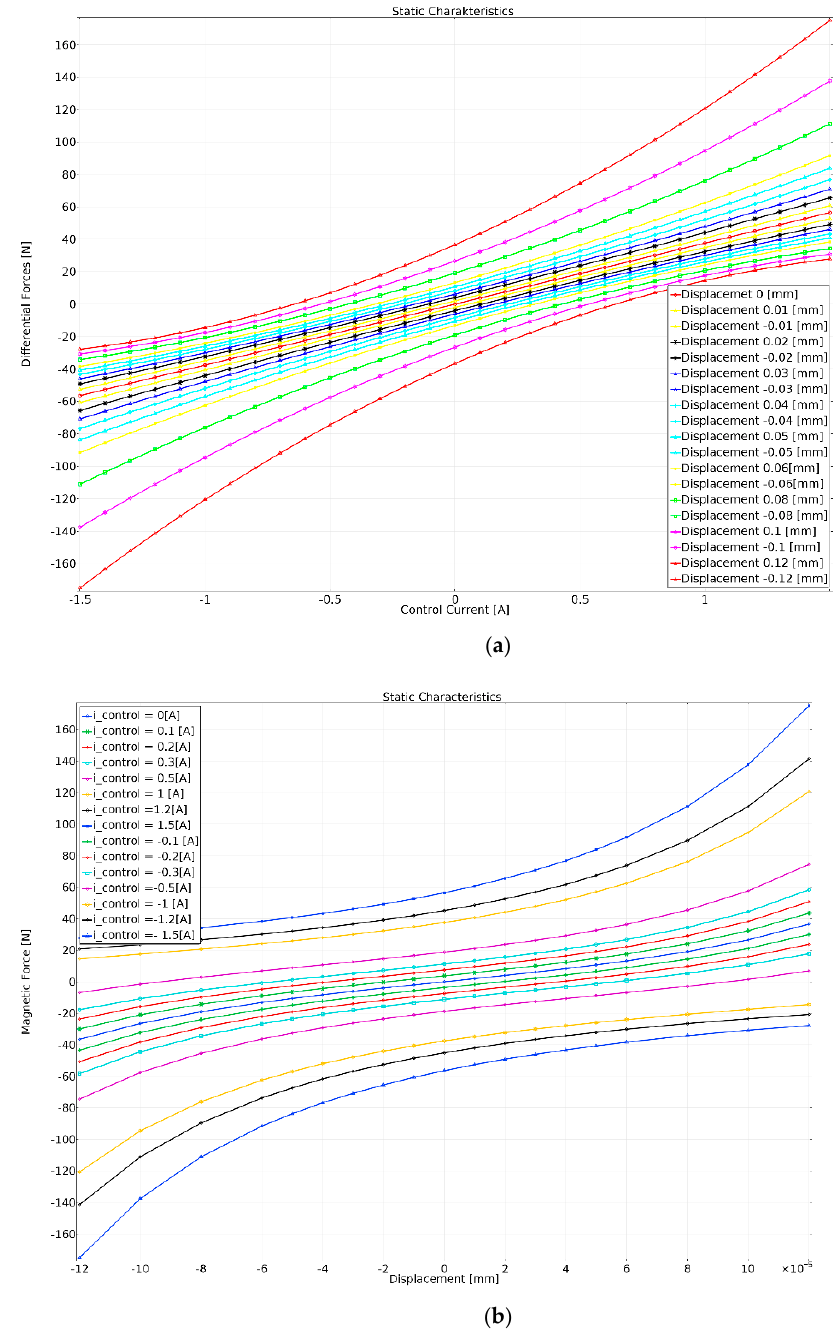
Figure 14. The static characteristics for different displacements of the rotorshaft raceway in the air gap ( a ) and various control currents ( b ). gap ( a ) and various control currents ( b